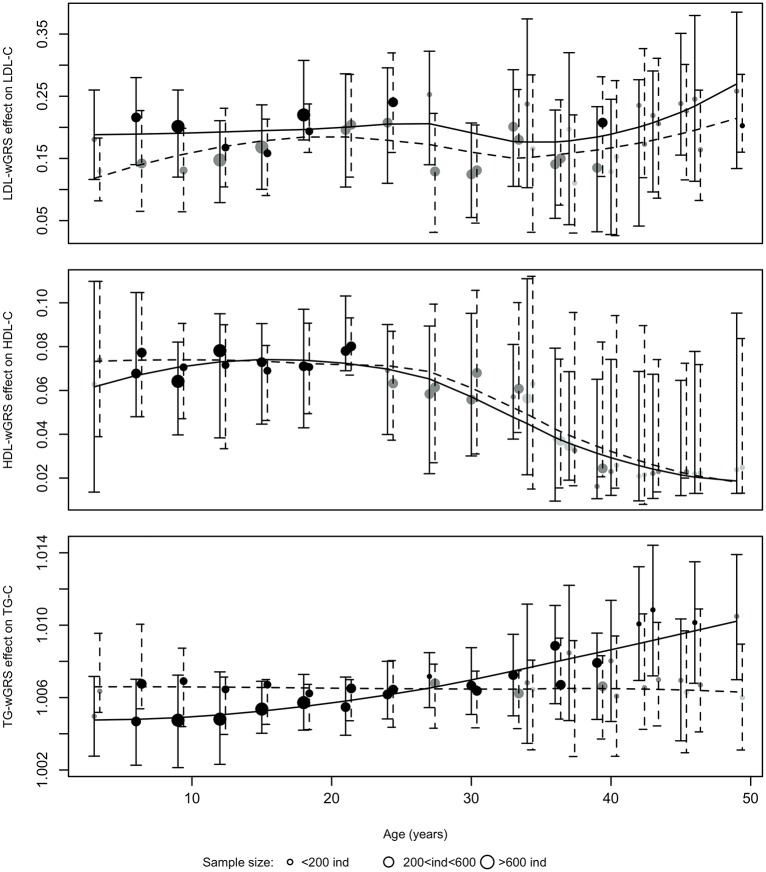
Age- and sex- stratified estimated effects of LDL-C wGRS (upper panel), HDL-C wGRS (middle panel) and TG wGRS (lower panel) on LDL-C, HDL-C and triglycerides levels respectively with color coded significance levels and studentized bootstrapped non-parametric 95% CI.For each age, the continuous error bars correspond to males and the dashed error bars directly next to them correspond to female models. Effect sizes are in mmol/L change per 1-sd change in wGRS for LDL-C and HDL-C and in odds ratio lipoprotein level change per 1-sd change in wGRS for triglycerides. Point sizes of the beta estimates reflect sample size (number of participants included in each age- and sex-specific regression analysis) Parameter estimates significance: Lightgrey, 0.05<p-val<0.01; Darkgrey, 1.x10-3<p-val<1.X10-6; Black, p-val≤1.X10-6. Black lines: smooth trend curves fitted by LOESS (Locally weighted non-parametric regression) to help visualise trends in the cross-sectional associations.